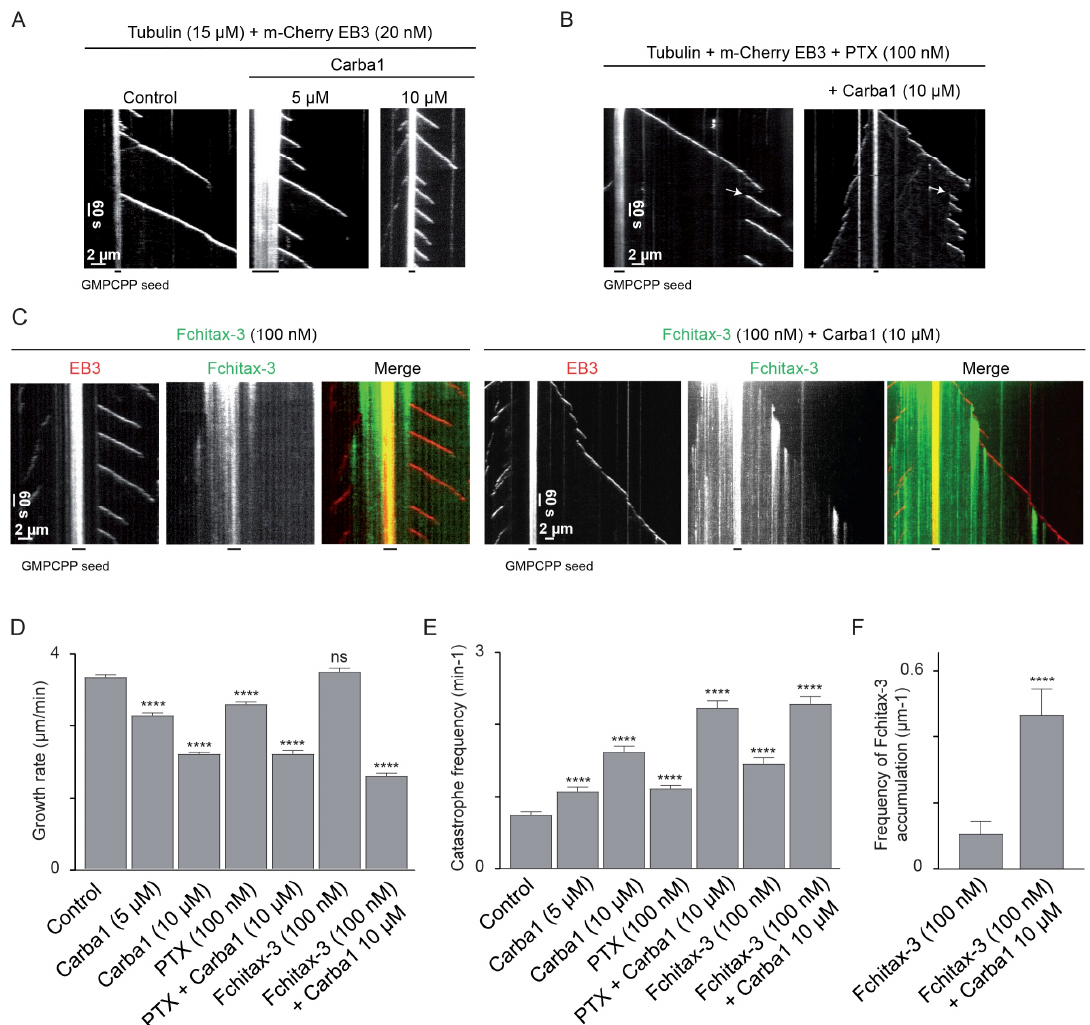
Figure 6. Carba1 binding to tubulin enhances the tubulin binding capacity of PTX. ( A – C ) Representative kymographs illustrating MT plus end growth in the presence of 15 µ M tubulin and 20 nM m-Cherry EB3 ( A ) without (control) or with 5 and 10 µ M Carba1; ( B ) PTX (100 nM) without or in combination with 10 µ M Carba1. Arrows indicate repeatedly rescued sites; ( C ) Fchitax-3 (100 nM) without or with 10 µ M Carba1. ( D , E ) Parameters of MT plus end dynamics determined using acquisitions as shown in ( A – C ) (three movies per condition, two independent experiments). The total number of analyzed growth events is 82 for 100 nM PTX, 72 for 100 nM PTX with 10 µ M Carba1, and 100 for all other conditions. Each value represents the mean ± SD. Each condition was compared to the control condition using a Mann–Whitney analysis. ( F ) Quantification of Fchitax-3 accumulation frequencies per MT unit length in the presence of 15 µ M tubulin and 20 nM mCherry-EB3 without ( n = 11) or with 10 µ M Carba1 ( n = 13). Values represent the mean ± SD. Both conditions were compared using a